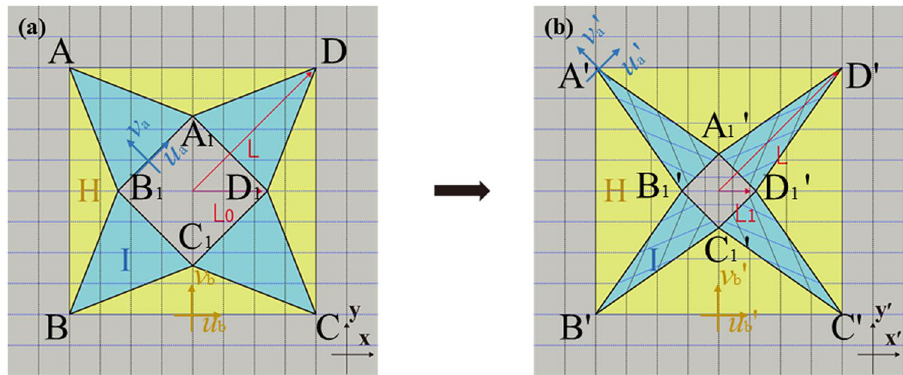
Figure 1. Schematic diagram of coordinate transformation for the case of square acoustic concentrator. A big square ABCD wraps a small square A 1 B 1 C 1 D 1 . The annular area around the small square is split into segment I and segment II. The external diameter of big square is L . ( a ) Virtual space. The size of internal square is L 0 . ( b ) Physical space. The size of internal square is L 1 . With the shrinkage of inner small square, segment I and segment II should be transformed